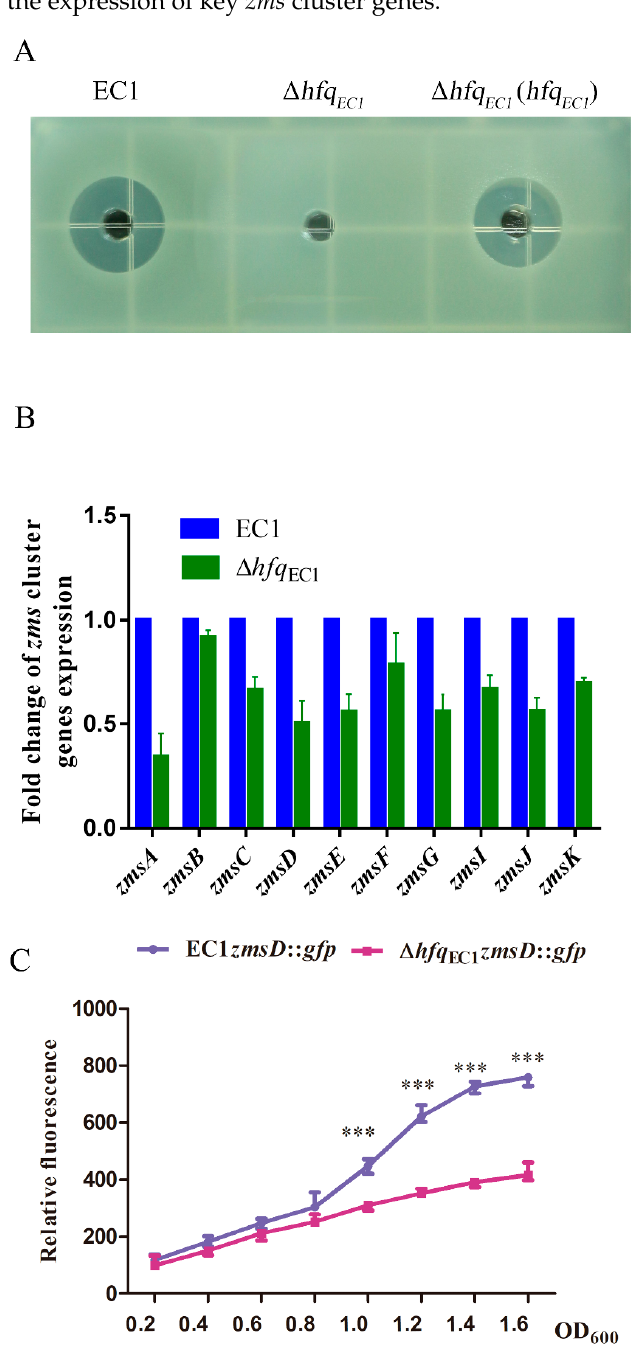
Figure 4. Expression of the zms cluster genes in Dickeya oryzae EC1 is regulated by Hfq EC1 . ( A ) Zeamine production assay. The filter-sterilized bacterial supernatants of D. oryzae EC1 and its derivatives were added to the wells in the bioassay plates, respectively. The bioassay plates were incubated at 37 °C for 24 h before photography. Experiments were repeated at least three times in triplicates. ( B ) QRT-PCR assay reveals the transcriptional regulation of key zms cluster genes by Hfq EC1 . ( C ) GFP promoter reporter fusion assay shows the regulation of zmsD gene by Hfq EC1 . Experiments were individually performed at least three times in triplicates. *** p < 0.01.